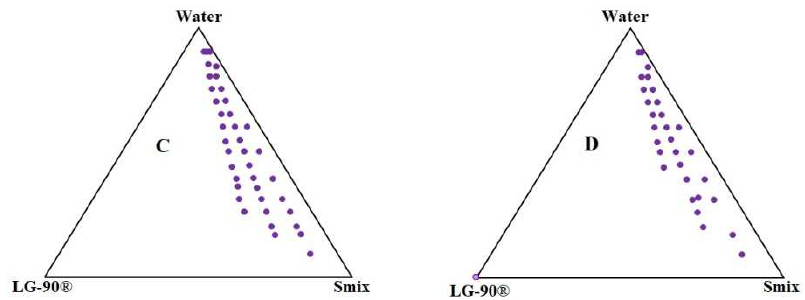
Figure 3. Ternary phase diagrams. ( A )-1:1; ( B )-1:2; ( C )-2:1; ( D )-1:3.